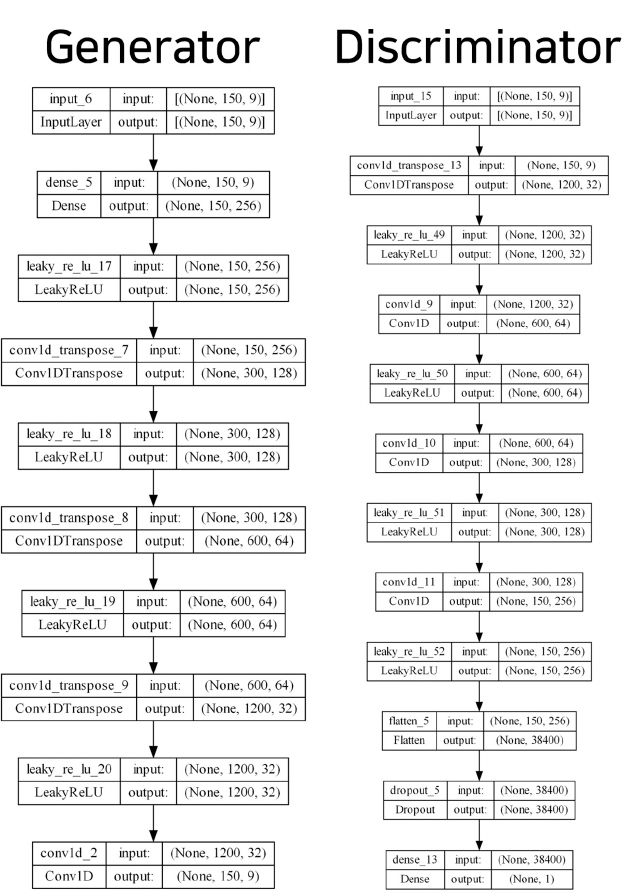
Figure 3. Generator and discriminator hyperparameters and model structure of the TN-GAN model.